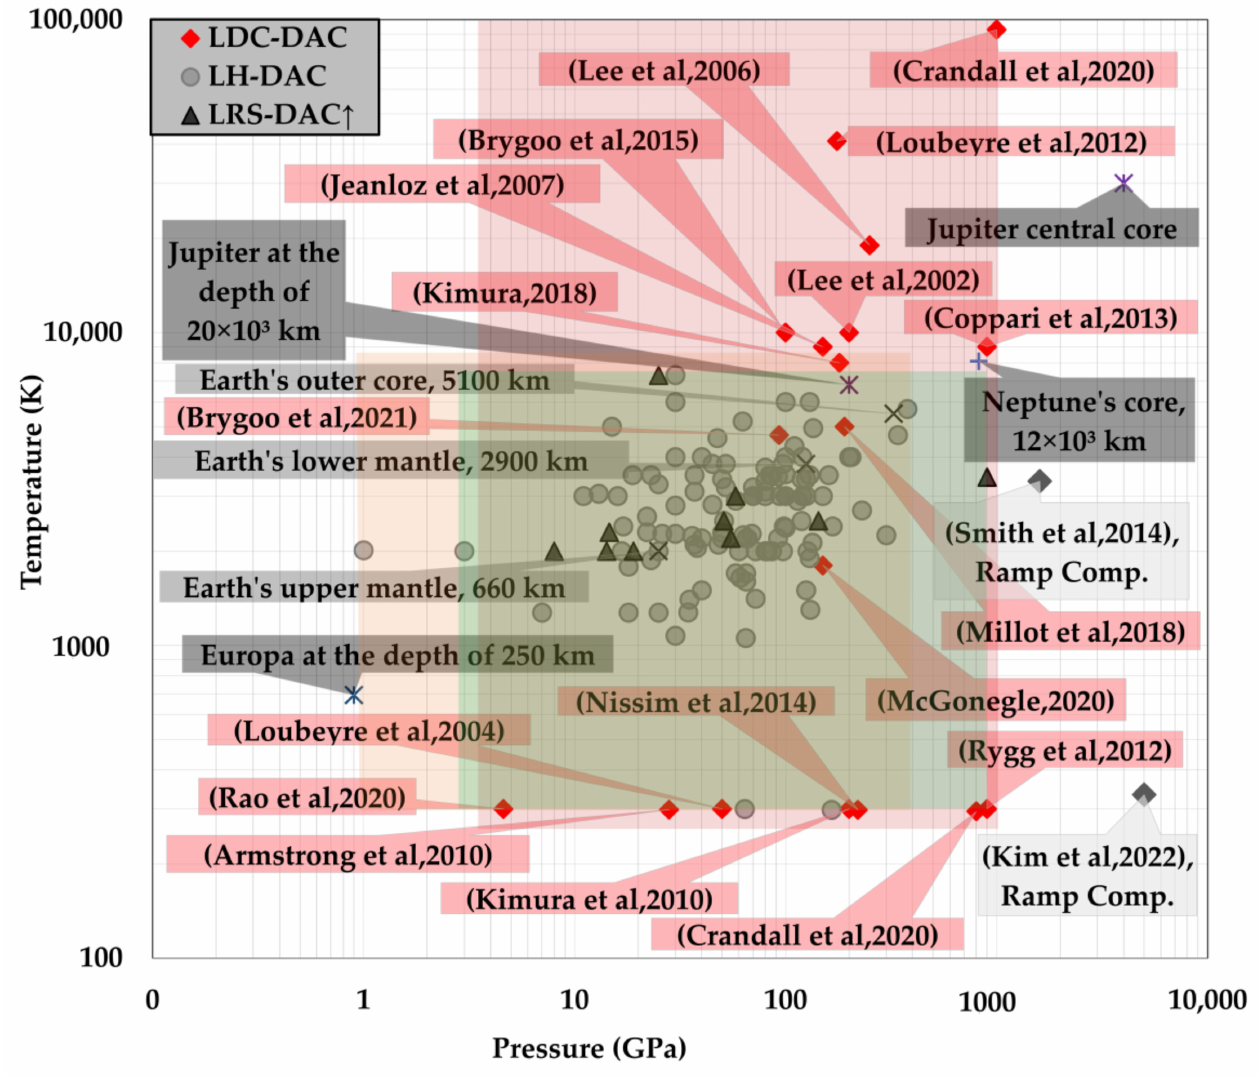
Figure 3. P–T diagram of L–DAC experimentation, showing region investigated by LDC–DAC sys- tems (Red) [21,28,30,57–60,73,74], LH–DAC systems (Orange) [8,20,75–190], and LRS–DAC systems (Green) [191–198]. For reference, P–T markers are also provided for several geophysical locations, including the P–T at a depth of 250 km of Europa’s oceans [199], 60–5100 km underneath the Earth’s surface [60,105,161], 12 × 10 3 km-deep in Neptune’s core [200], (20 to 71.5) × 10 3 km-deep in Jupiter’s core [201,202] and two LDC experiments with ramp -compression